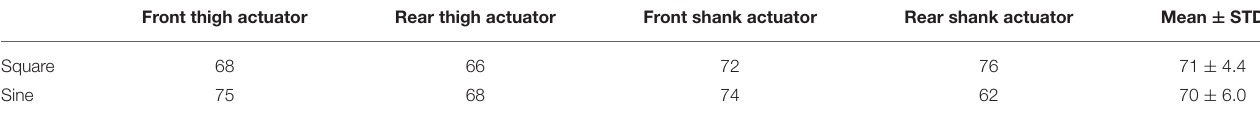
TABLE 2 | NRMSE [goodness of fit, %, calculated using Equation (10)] between the simulated force F sim and the experimental force F exp during the dynamic tests. Front thigh